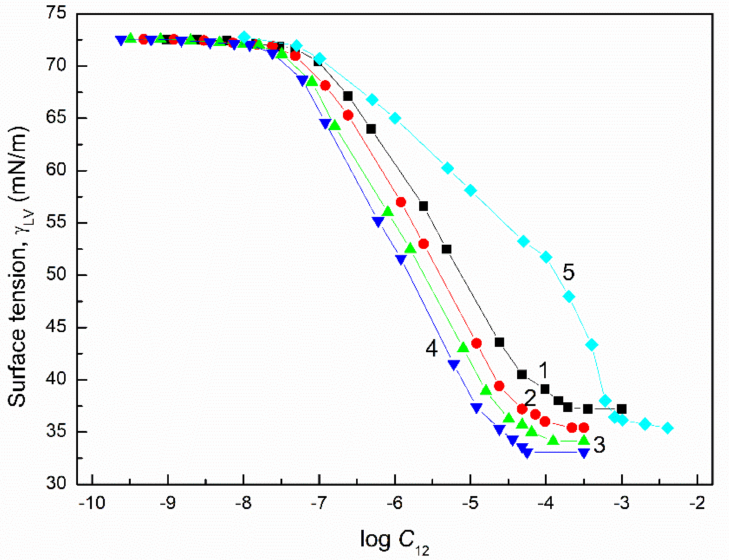
Figure 7. A plot of the surface tension ( γ LV ) of the aqueous solution of the SF and TX165 mixture vs. the logarithm of its concentrations ( C 12 ). Curves 1 − 4 correspond to the SF mole fractions in the mixture equal to 0.2, 0.4, 0.6, and 0.8, respectively. Curve 5 corresponds to the sum of the SF and TX165 concentrations, where the TX165 concentrations changed from 0 to 0.004 mole/dm 3 and the SF concentration changed from 1.93 × 10 − 10 to 3.86 × 10 − 5 mole/dm 3 , as applied in the literature [22,24] for their aqueous solution surface tension